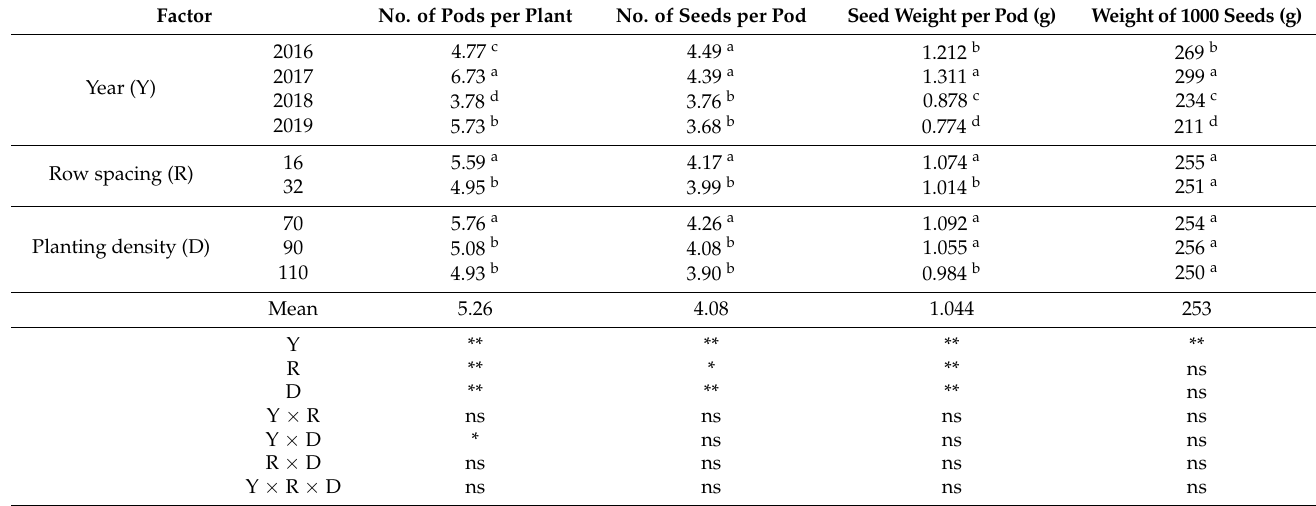
Table 6. Pea yield components depending on row spacing and plant density across the